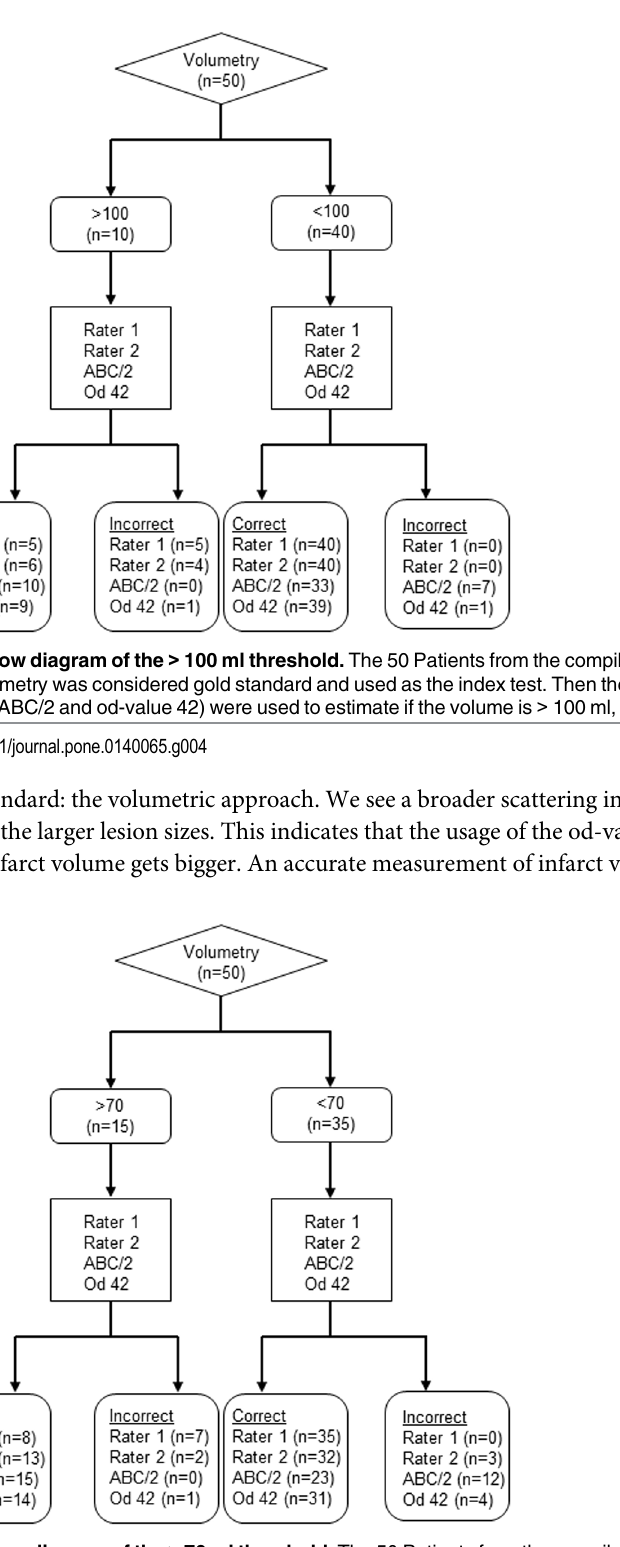
Fig 5. Flow diagram of the > 70 ml threshold. The 50 Patients from the compiled dataset were analyzed. The volumetry was considered gold standard and used as the index test. Then the other methods (Rater 1, Rater 2, ABC/2 and od-value 32) were used to estimate if the volume is > 70 ml, respectively < 70